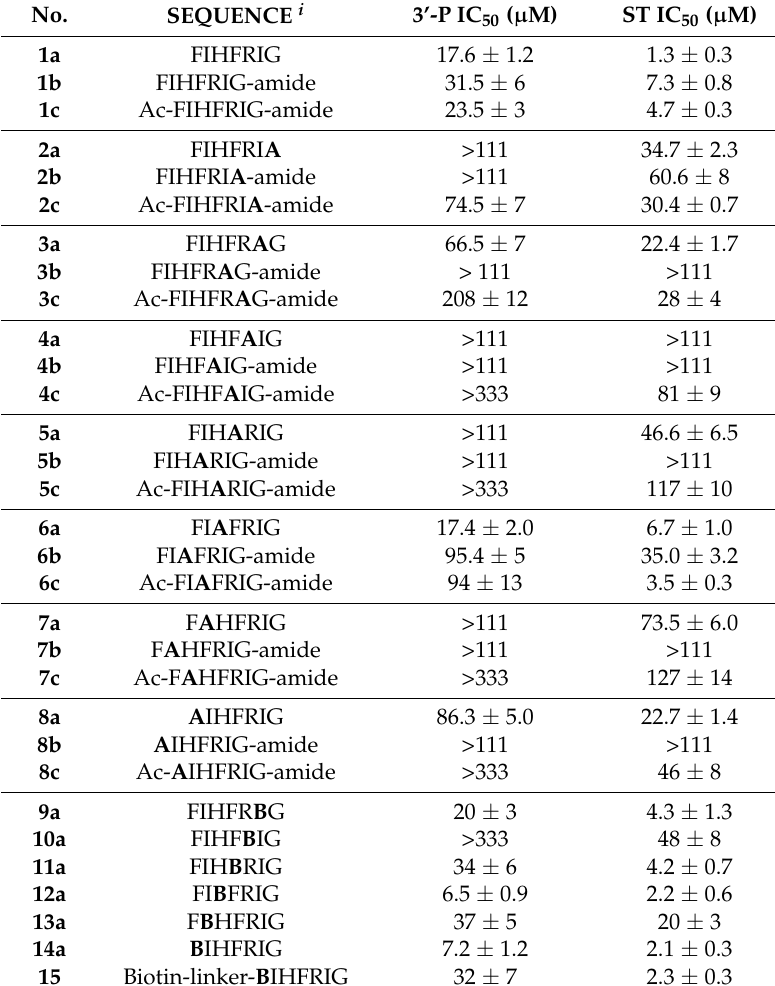
Table 1. Structures of peptides and 3 (cid:48) -P and ST-inhibitory potencies in in vitro IN assays.